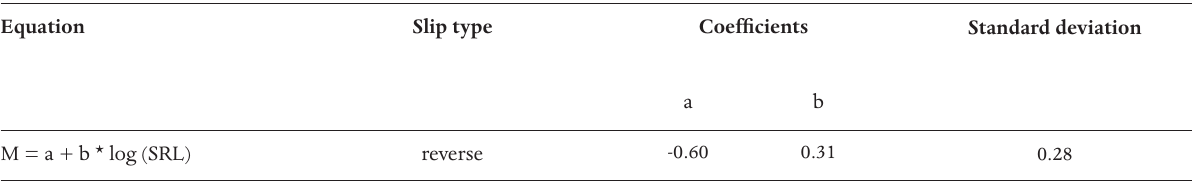
Table 3. Regressions of surface rupture length (SRL in km) and average displacement (AD in m) [Wells and Coppersmith 1994].